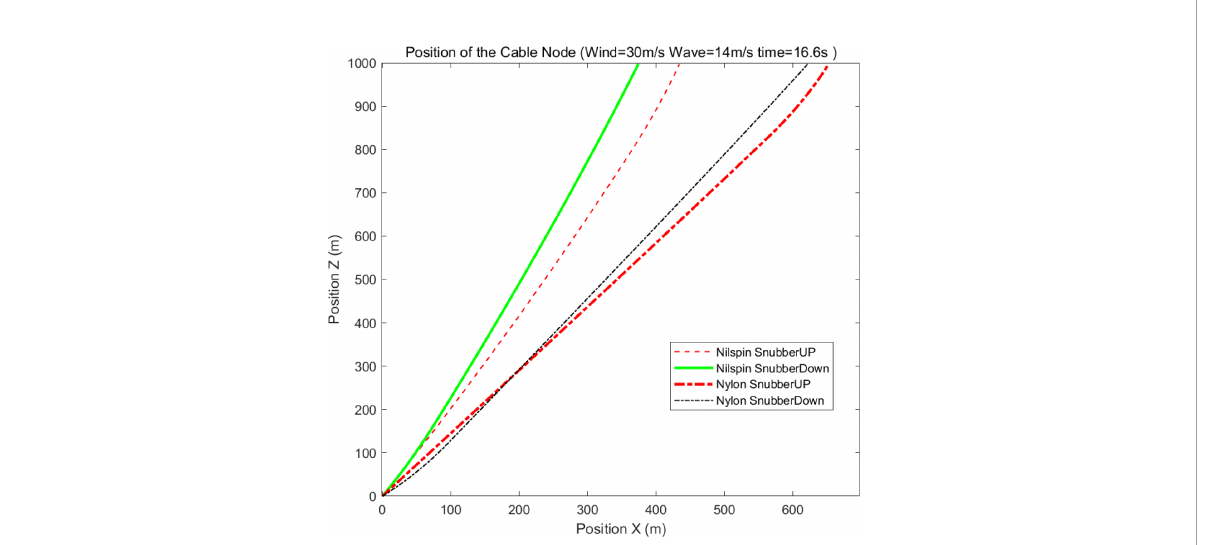
FIGURE 3 Shape of the mooring line for a wind speed of 30 m/s, wave speed of 14 m/s, and peak wave period of 16.6 s for different con fi gurations of the mooring line.